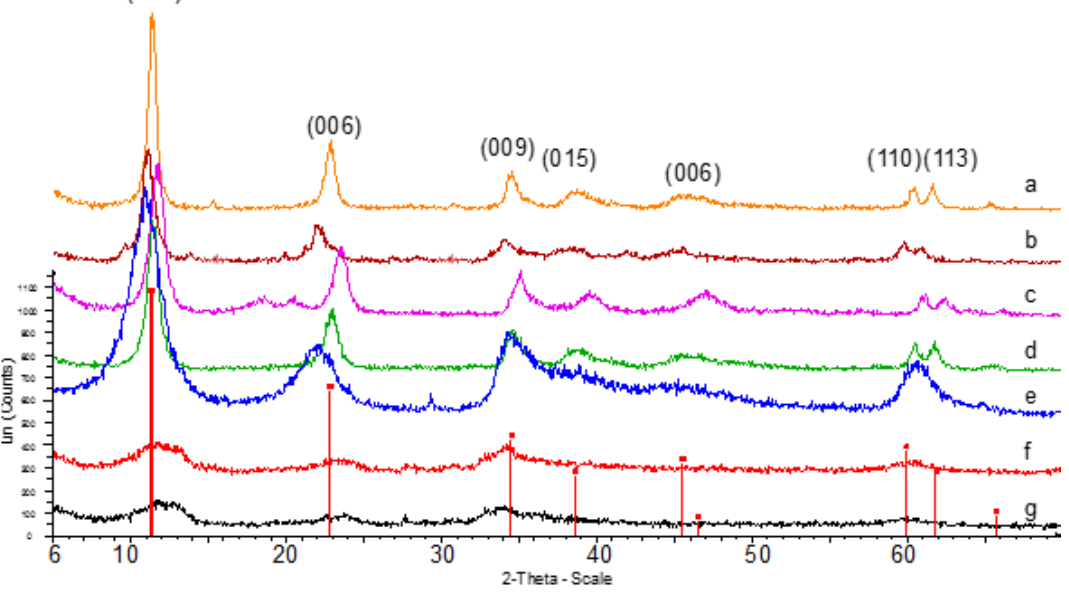
Figure 2. XRD patterns of the hydrotalcite-type samples. (a) HTMgAl1, (b) HTMgAl2, (c) HTMgAl3, (d)HTNiMgAl1, (e) HTNiMgAl2, (f) HTCuZnCr and (g) HTCuCr. Red line: JCPDS file (089-0460